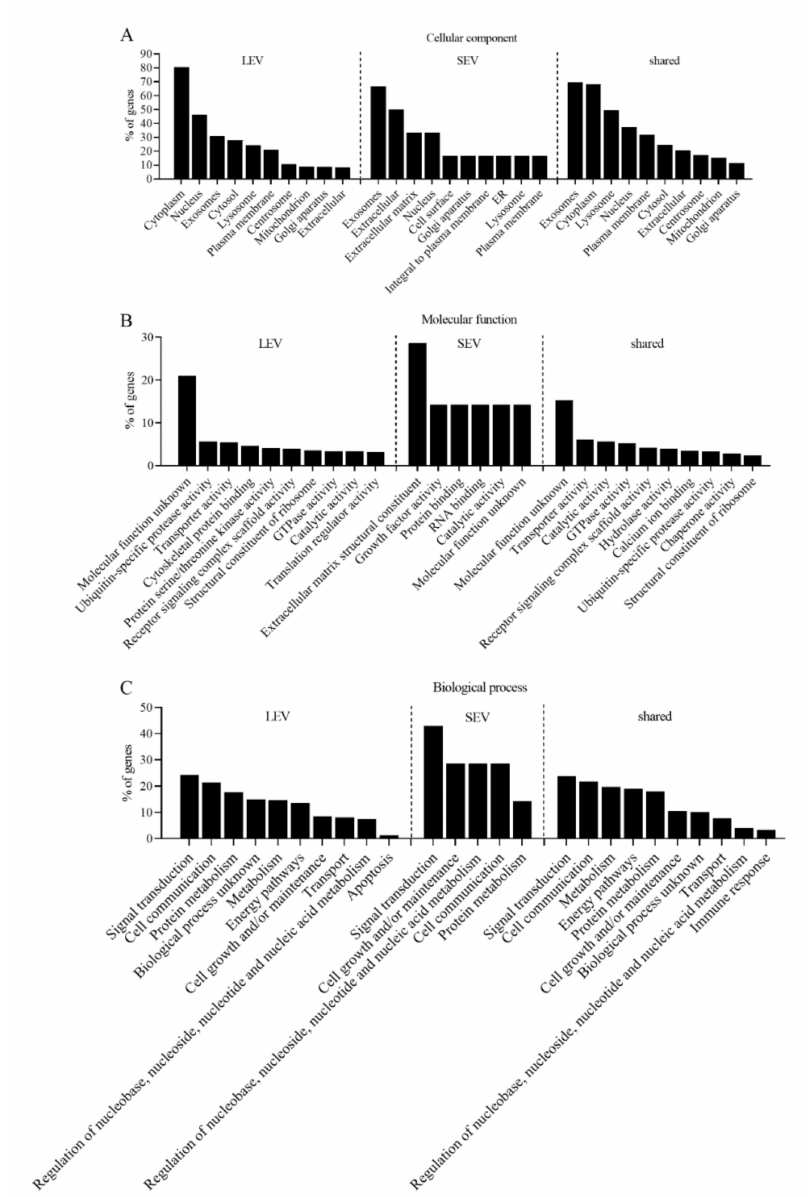
Figure 4. Gene ontology (GO) annotations of proteins detected in both experiments in LEV only (539 proteins), SEV only (seven proteins), or shared by LEV and SEV (684 proteins). Ranking is according to the database in FunRich and ordered by the percentage of genes per GO term. ( A ) Cellular component annotations. ( B ) Molecular function annotations. ( C ) Biological process annotations. A protein–protein interaction network (STRING) of all ESCRT associated proteins, small